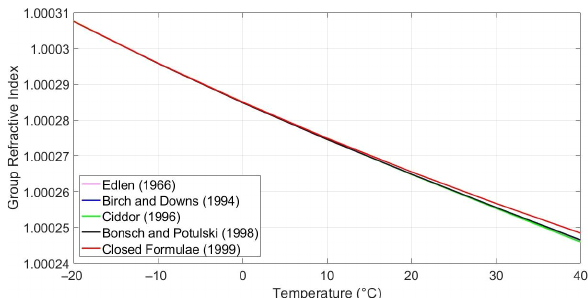
Figure 6. Effect of temperature on group refractive index of air calculated in five EDM correction models